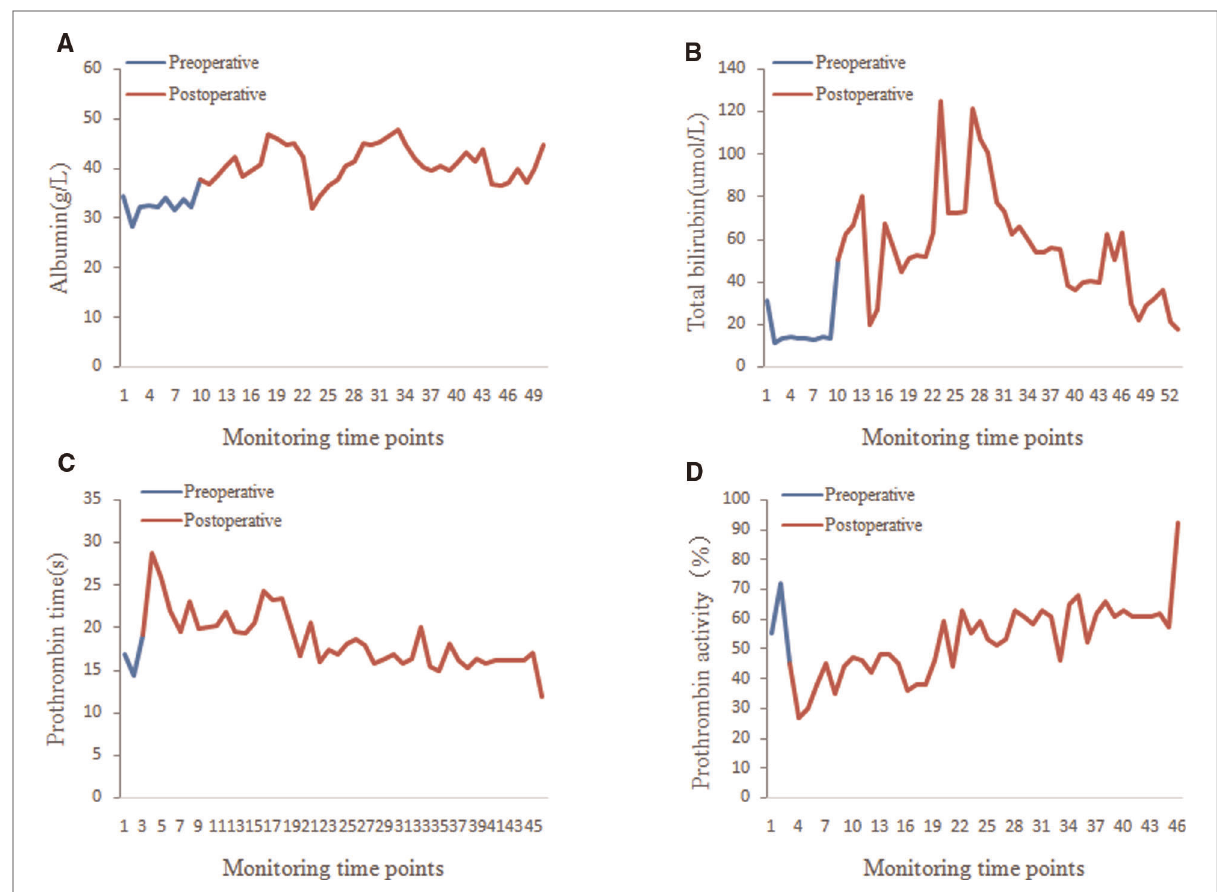
FIGURE 3 Curve of postoperative liver function-related indexes. Postoperative changes in albumin ( A ) total bilirubin ( B ) prothrombin time ( C ) and prothrombin activity ( D